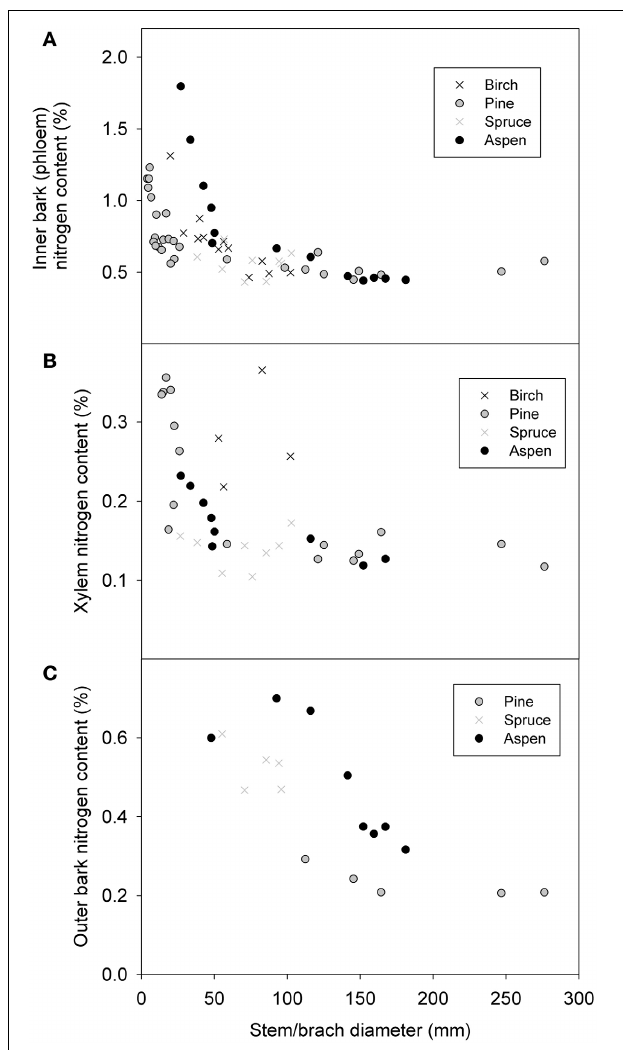
FIGURE 3 | Nitrogen concentration of living bark (A), xylem (B), and whole bark (C) as a function of stem/branch diameter. The data measurement points in living bark and xylem were from 8 trees (4